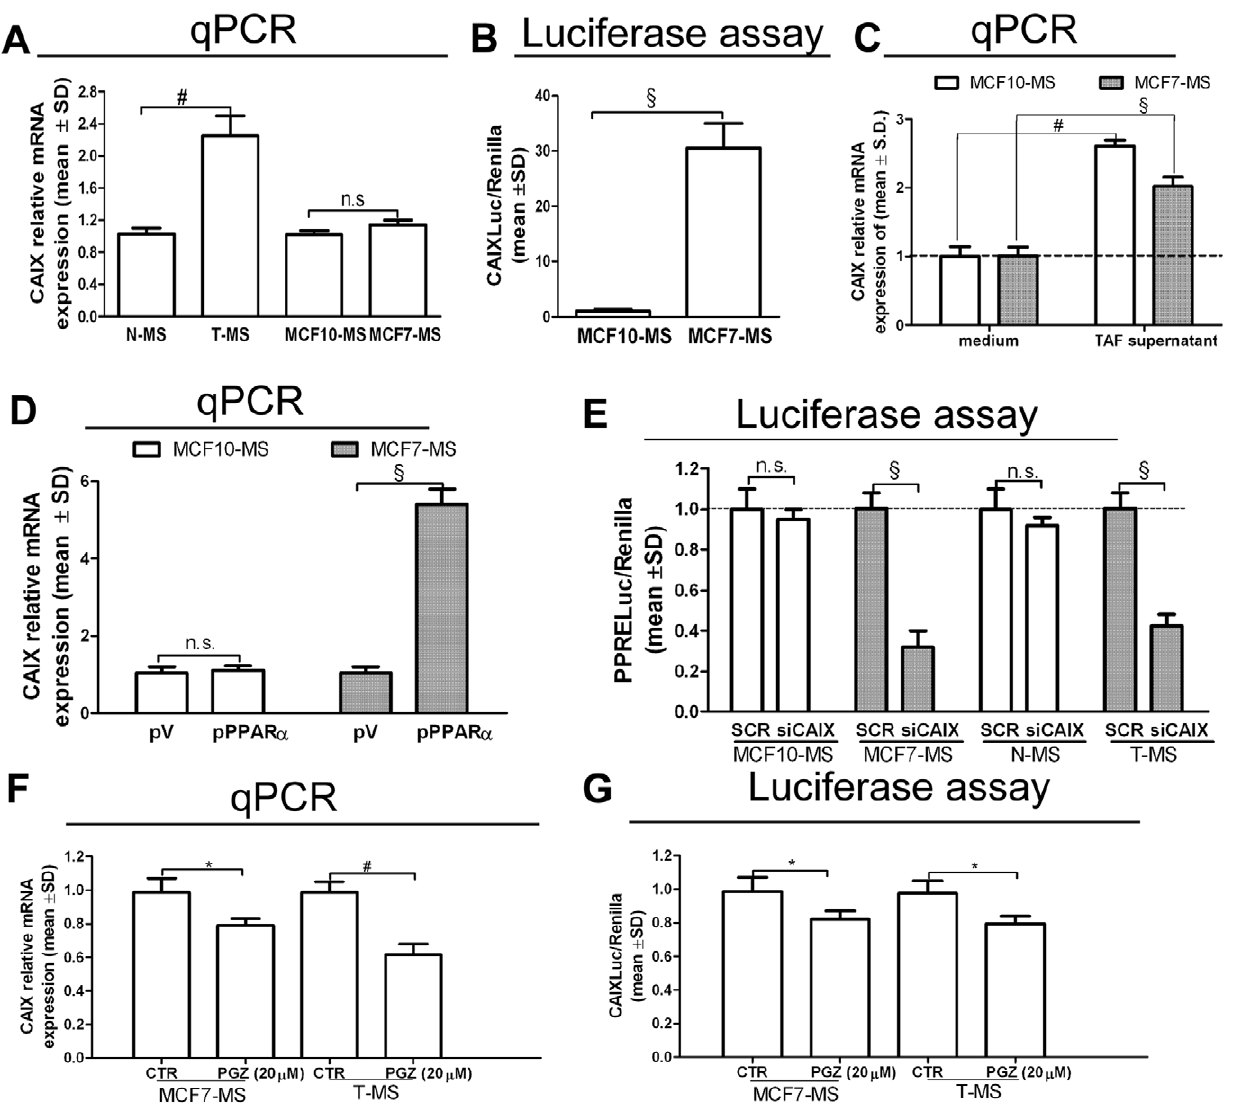
Figure 6. CAIX is under the control of the PPAR a /HIF1 a interplay in breast CSCs. (A) CAIX mRNA qPCR analysis in MCF10/MCF7-MS and in N/T-MS (samples 1–5, n=5). (B) CAIXLuc activity in MCF10-MS and MCF7-MS. (C) CAIX mRNA qPCR analysis in TAF supernatant (10%, 24 h)-exposed MCF7-MS and MCF10-MS. (D) CAIX mRNA qPCR analysis in pV/pPPAR a .(24 h)-transfected MCF10-MS and MCF7-MS. (E) PPRELuc activity in SCR/siCAIX (72 h)-transfected MCF10/MCF7-MS and N/T-MS (samples 16–18). CAIX mRNA qPCR analysis (F), CAIXLuc activity assay (G) in PGZ (20 m M, 24 h)- exposed MCF7-MS and T-MS (samples 19–20): Data are expressed as mean 6 S.D., n=3 unless otherwise specified, * p , 0.05, # p , 0.01, 1 p , 0.005, ANOVA test. n.s.: not